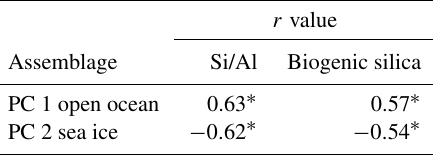
Table 4. Correlation ( r ) between each PC component and Si/Al and biogenic